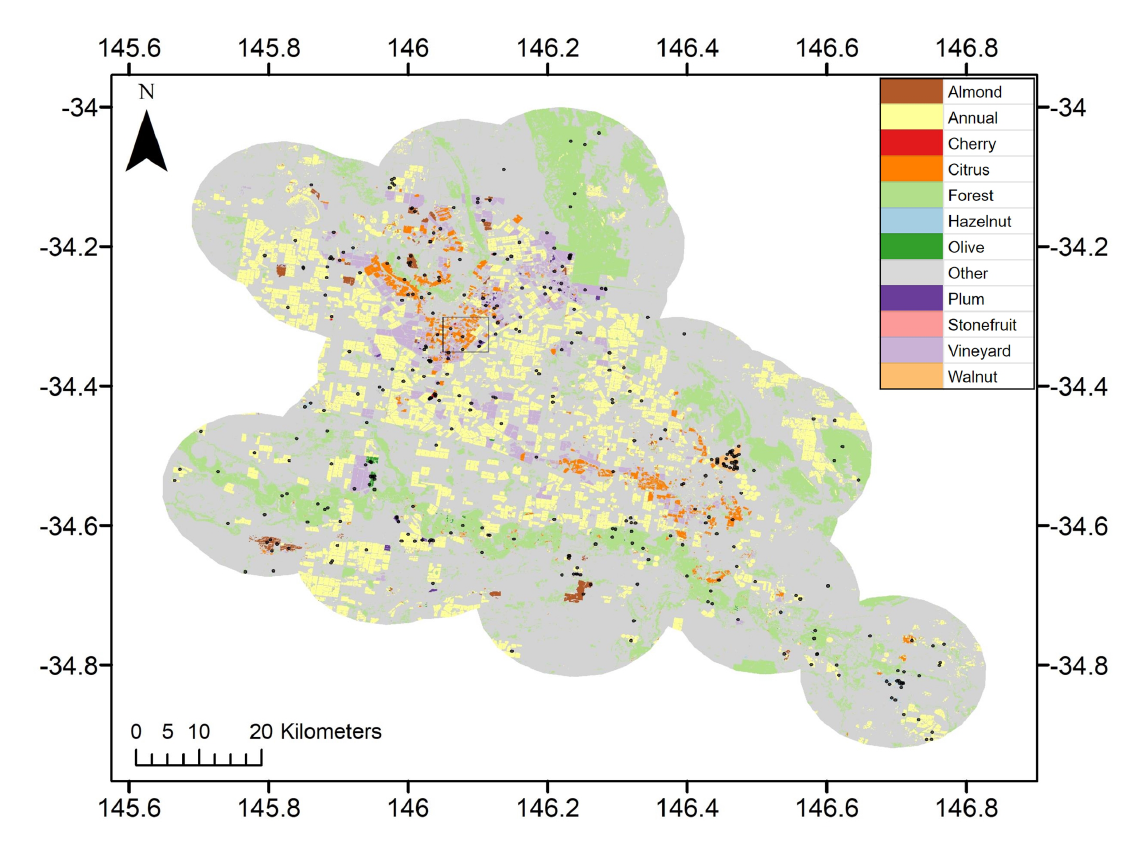
Figure 16. Final classified map using S2(10) + S1(2) time series features, and a majority pixel proportion threshold of 60%. The location of the detailed maps in Figure 13 is indicated by the black inset rectangle, and points show the location of the validation